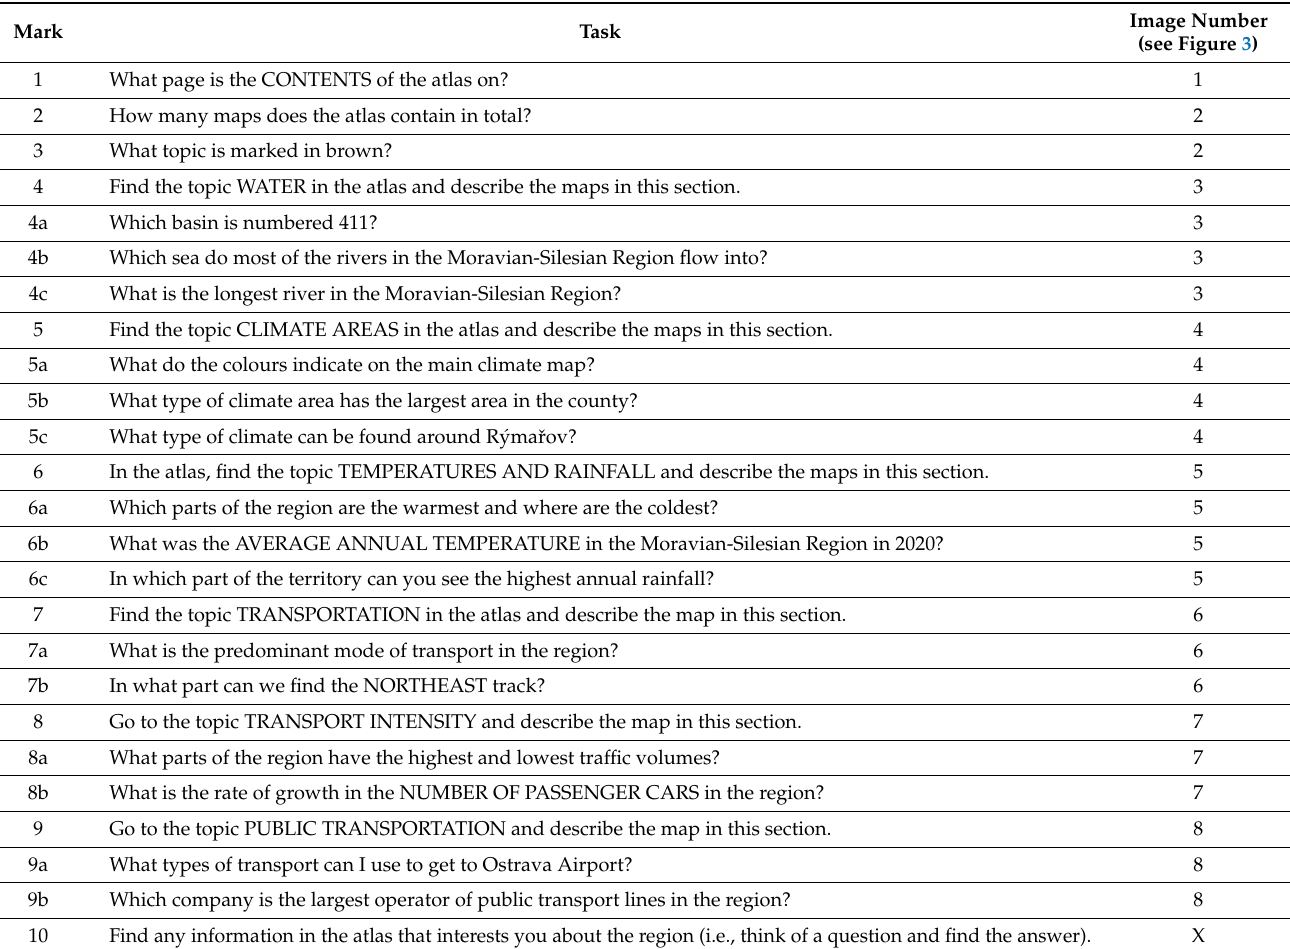
Table 1. The test scenario in the study for the Atlas of the Moravian-Silesian Region . The related page of the atlas is specified in the third